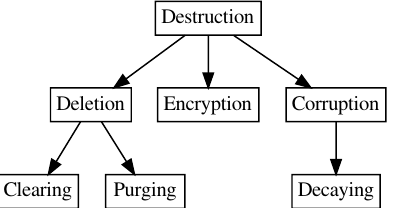
Figure 2. Destruction techniques